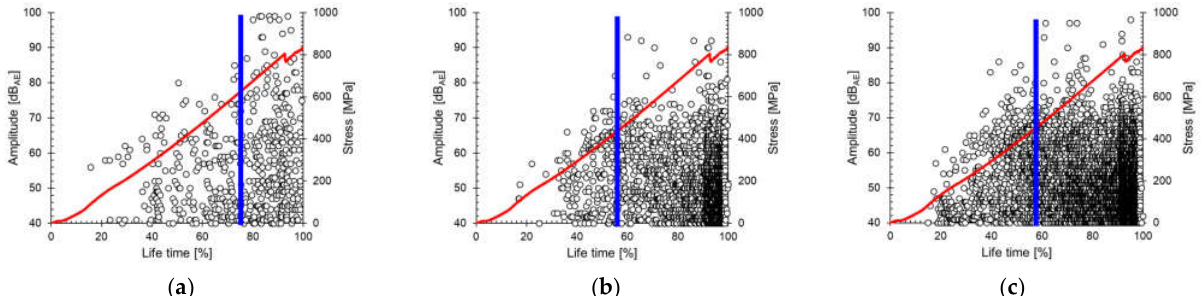
Figure 8. Distribution of cumulative hits according to fracture mode: ( a ) matrix cracking, ( b ) interfacial failure, and ( c ) fiber failure .